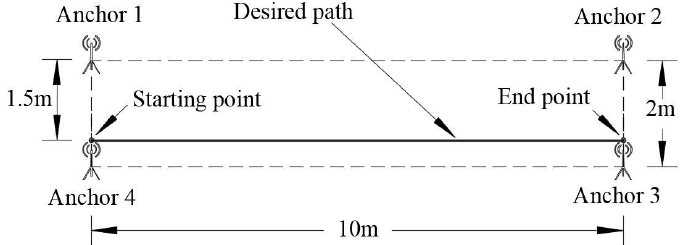
Figure 7. Layout of test site.